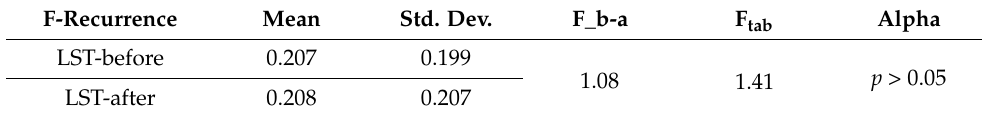
Table 4. Statistical analysis on the F-recurrence distribution ex-ante and ex- post 2010. F-Recurrence Mean Std. Dev. F_b-a F tab Alpha LST-before 0.207